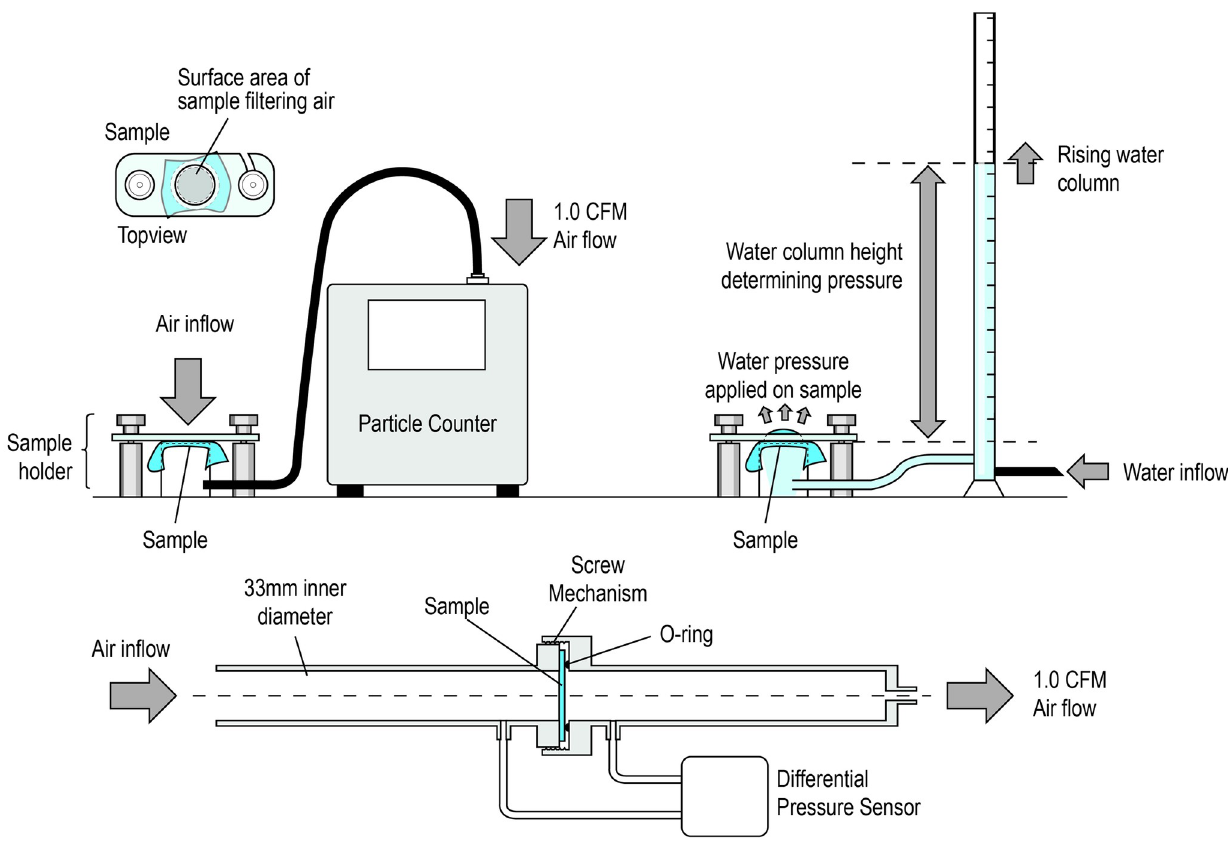
Fig 1. Schematic diagrams depicting the tests used to measure filter efficiency (top left), splash resistance (top right), and breathability of the materials examined in this